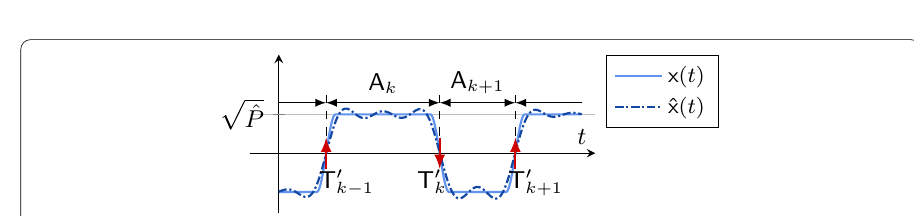
x ( t ) . The distances between the ˆ